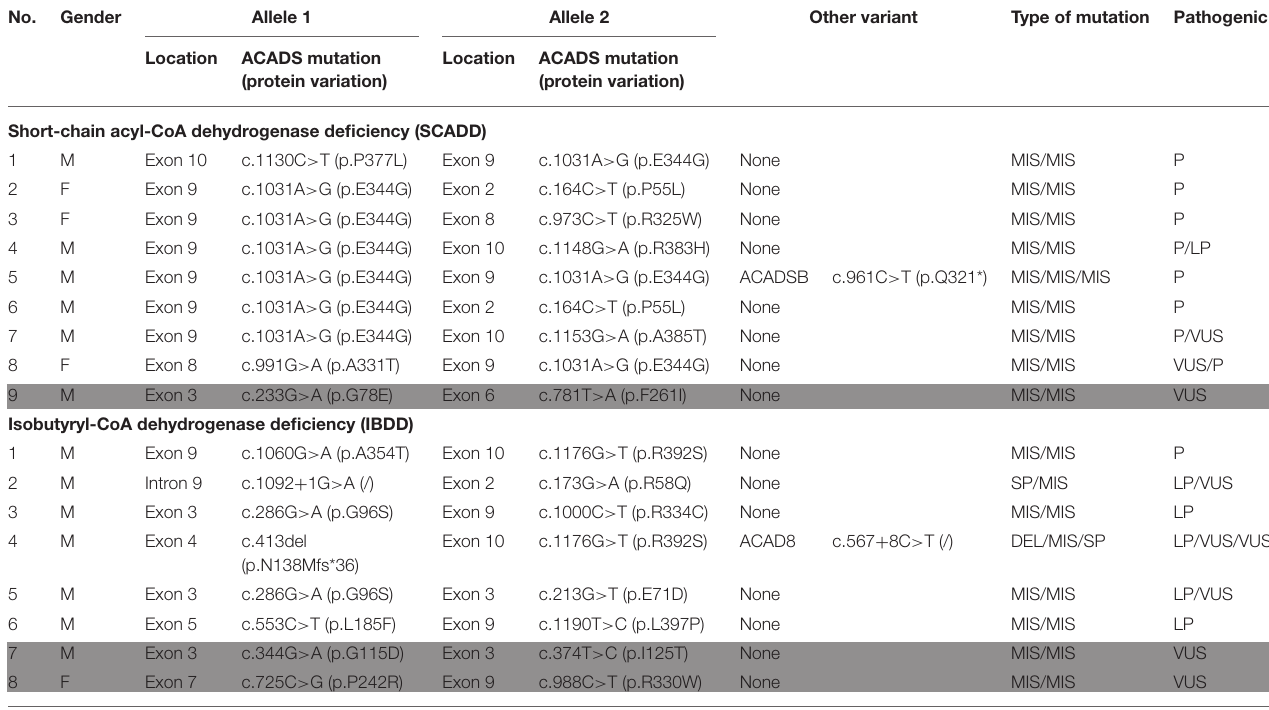
TABLE 2 | Molecular characteristics for the SCADD and IBDD individuals identified with two pathogenic variants. No. Gender Allele 1 Allele 2 Other variant Type of mutation Pathogenic Location ACADS mutation Location ACADS mutation (protein variation) (protein variation) Short-chain acyl-CoA dehydrogenase deficiency